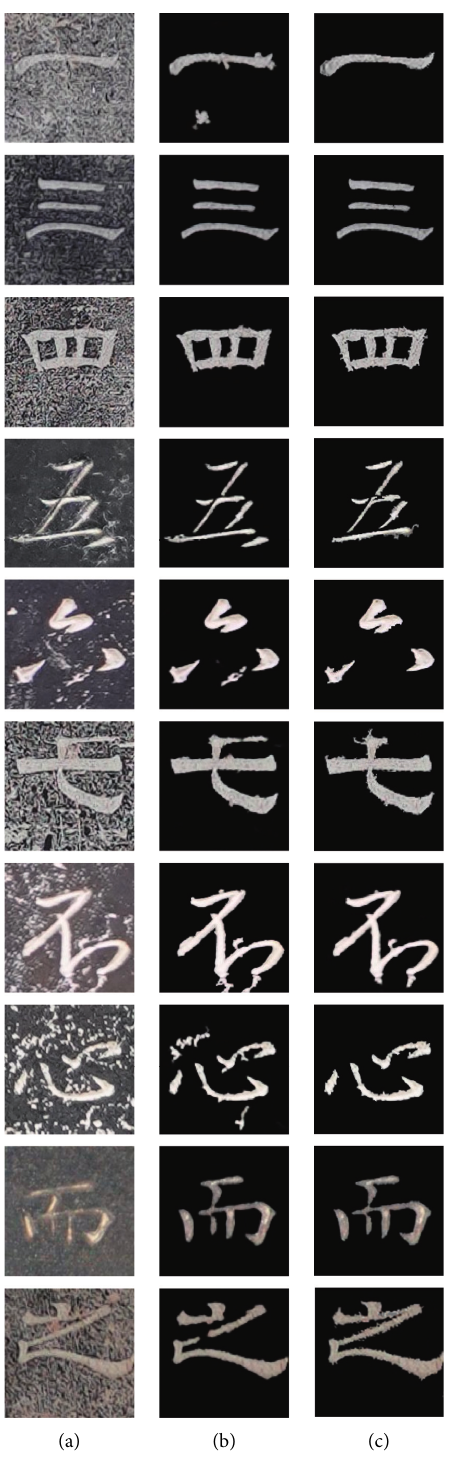
Figure 9: The image denoising results. (a) The noisy images. (b) The denoised results. (c) The